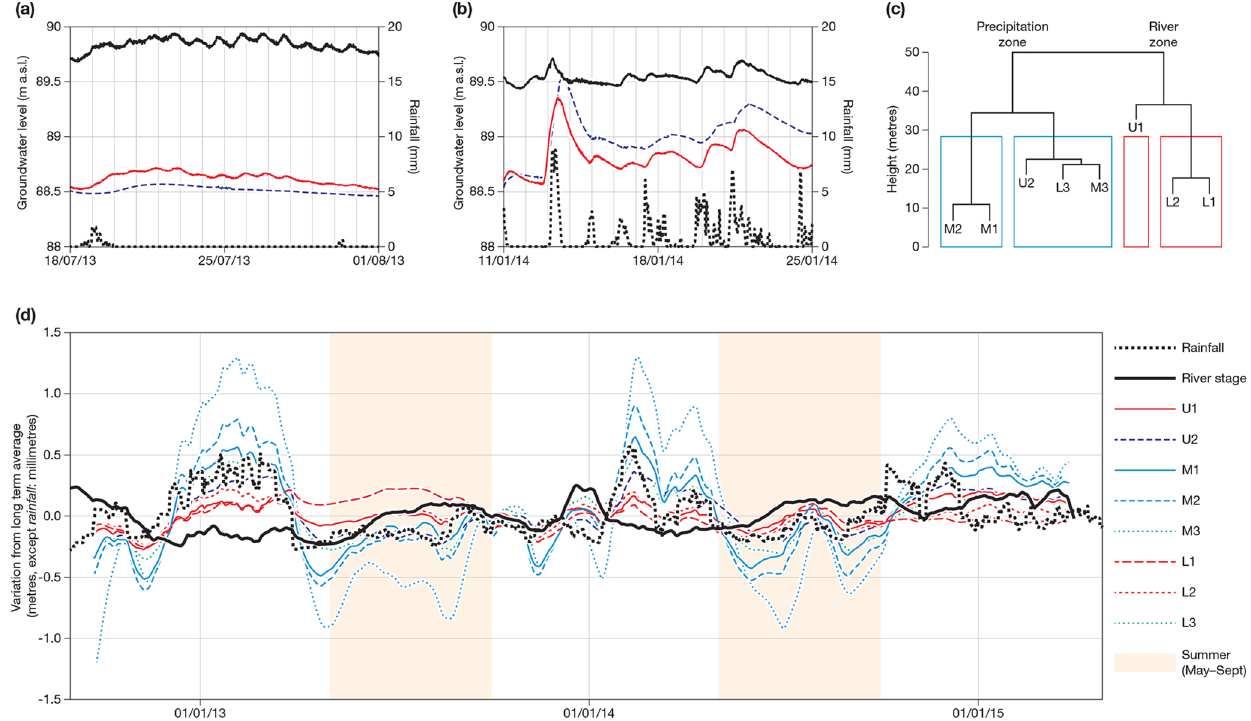
Figure 3. Groundwater levels, river stage, and precipitation. (a) Groundwater levels in the upper sandur during a 14d dry period in summer (for the legend, see panel d ). (b) Groundwater levels in the upper sandur during a 14d rainy period in winter (for the legend, see panel d ). Piezometer U1 (solid) is 20m from the river; piezometer U2 (dashed) is 90m from the river. (c) Dendogram obtained by hierarchical cluster analysis of groundwater-level data from sandur piezometers (piezometer locations in Fig. 1). The highest-level break shows two clusters representing piezometers where groundwater is influenced dominantly by local precipitation (U2, M1, M2, M3, L3) and piezometers where groundwater is influenced by the meltwater river (U1, L1, L2). Boxes show the four optimal sub-clusters indicated by data standardisation. (d) Monthly running mean of river stage (m), hourly precipitation (mm), and groundwater level (m), as a variation from the long-term average (LTA =